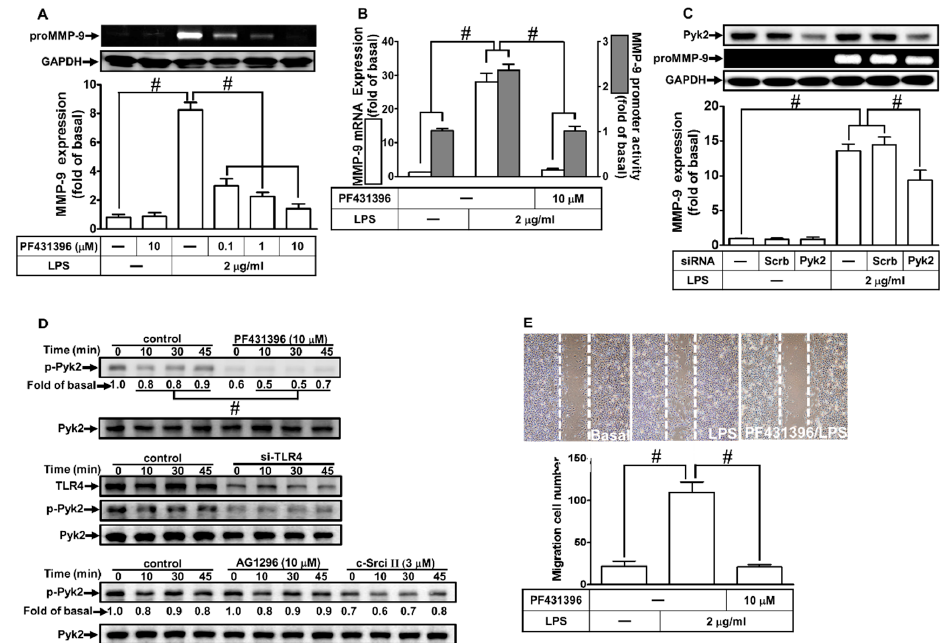
Figure 4. Proline-rich tyrosine kinase 2 (Pyk2) is involved in LPS-induced MMP-9 expression and cell migration. ( A ) RBA-1 cells were pretreated with PF431396 (0.1, 1, and 10 μ M) for 1 h, and then incubated with LPS (2 μ g/mL) for 24 h. The levels of MMP-9 were determined by gelatin zymography. The GAPDH level of cell lysates was assayed by western blot. ( B ) Cells were pretreated with PF431396 (10 μ M) for 1 h, and then incubated with LPS (2 μ g/mL) of 4 h for mRNA expression or 6 h for promoter activity. The mRNA expression and promoter activity of MMP-9 were determined by real-time PCR and promoter assay, respectively. ( C ) Cells were transfected with scrambled (Scrb) or Pyk2 siRNA, and then incubated with LPS (2 μ g/mL) for 24 h. The medium and cell lysates were collected to respectively determine the levels of MMP-9 by gelatin zymography, and the levels of GAPDH and Pyk2 by western blotting. ( D ) Cells were pretreated with or without PF431396 (10 μ M), c-Src inhibitor II (3 μ M), or AG1296 (10 μ M) for 1 h, or separately transfected with TLR4 siRNA, and then challenged with LPS (2 μ g/mL) for the indicated time intervals (0, 10, 30, and 45 min). The phosphorylation of Pyk2 was determined by western blotting. ( E ) Cells were pretreated with PF431316 (10 μ M) for 1 h and then incubated with LPS (2 μ g/mL) for 48 h. The number of cell migrations was determined (magnification = 40×). Data are expressed as mean ± SEM of three independent experiments. # p < 0.01 as compared with the cells exposed to vehicle or LPS, as indicated.